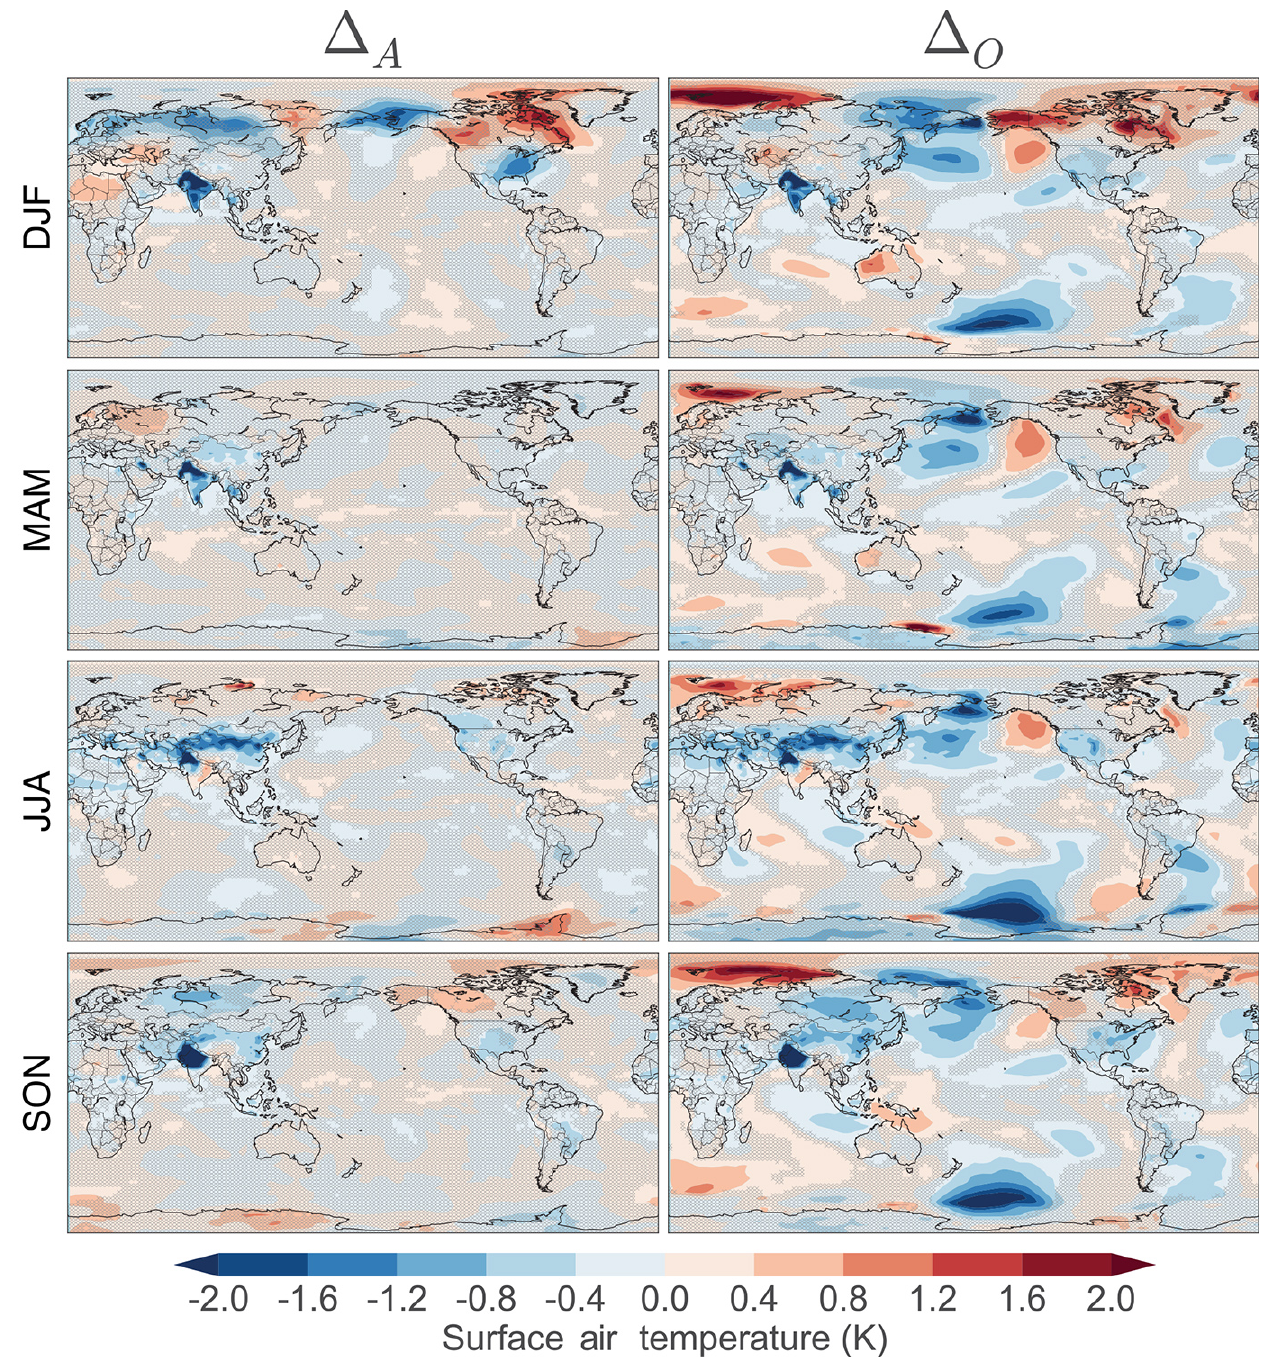
Figure 3. Difference in surface air temperature (K) by season due to irrigation with fixed SST ( (cid:49) A ) and with interactive SST ( (cid:49) O ). Differences not significant at the 0.05 level are hatched